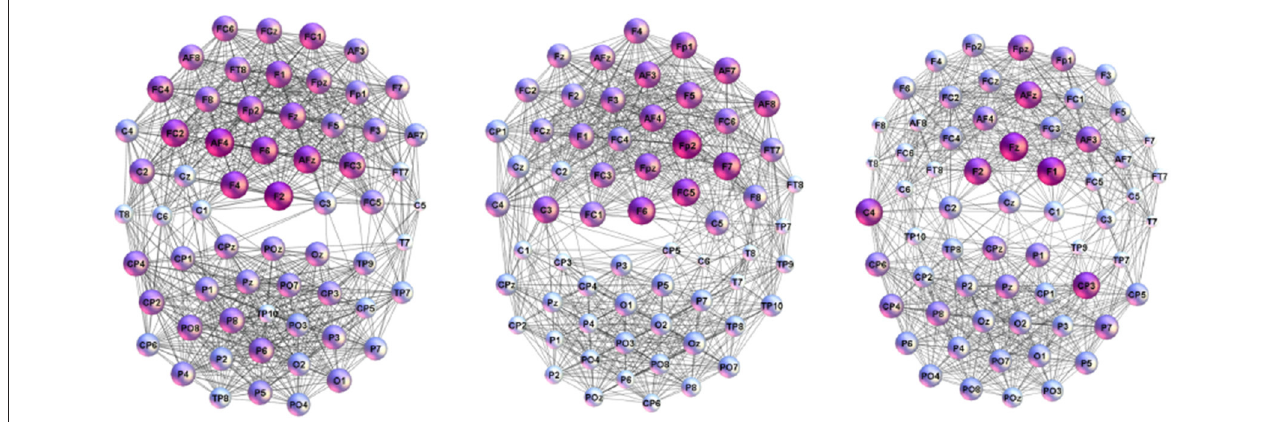
FIGURE 2 | Examples of the connectivity patterns occurring during the spoken communications inside individual brains of the listeners (Left to Right) L 16 , L 21 , and L 23